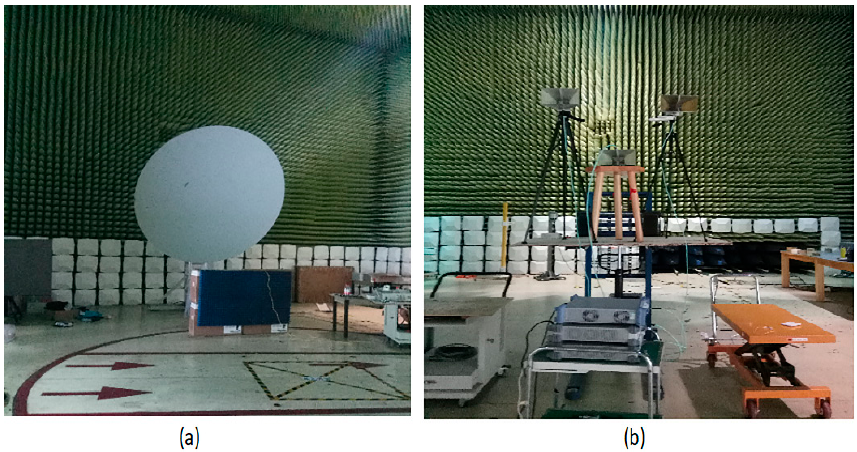
Figure 10. Settings of the experiment. ( a ) Reflective surface and ( b ) horn antennas.